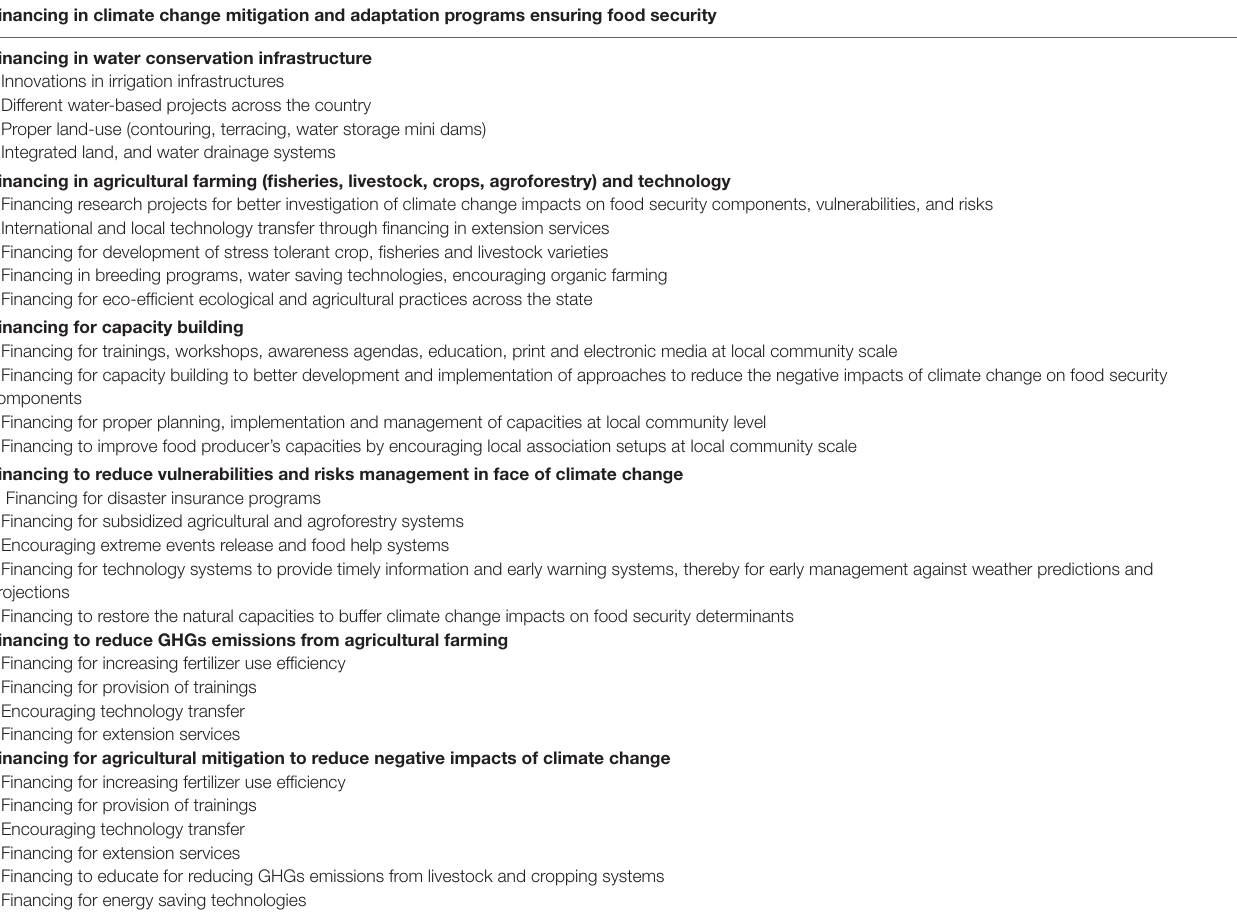
TABLE 2 | Potential and necessary areas for financing in adaptation and mitigation programs to reduce the risks to food security in face of climate change. Financing in climate change mitigation and adaptation programs ensuring food